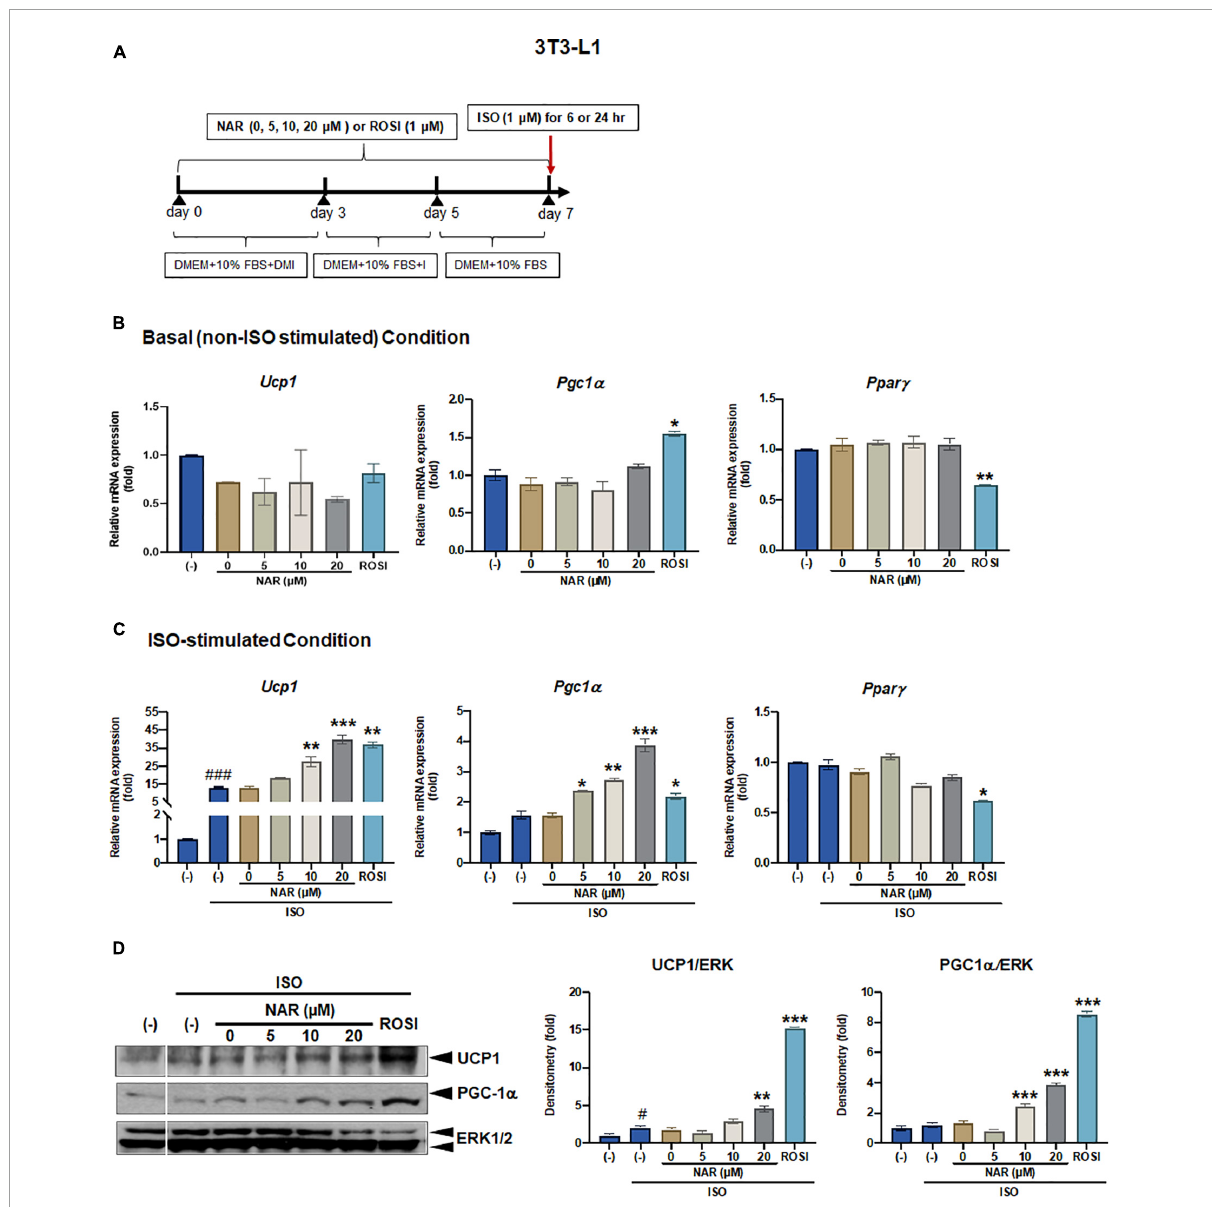
FIGURE1 Naringenin dose-dependently enhances UCP-1 expression in isoproterenol (ISO)-stimulated 3T3-L1 adipocytes. 3T3-L1 cells were differentiated in the presence or absence of NAR (5, 10, 20 µ M) for 7 days. ROSI (1 µ M) was included as a positive control. On day 7, the cells were stimulated with isoproterenol (ISO, 1 µ M) or the vehicle control (H 2 O) for 6 h for mRNA analysis or 24 h for protein analysis. (A) A diagram of the cell treatment and timeline. As described in the Materials and Methods, DMEM + 10% FBS + DMI refer to DMEM containing 10% FBS, 0.5 mM/L 3-isobutyl-1-methylxanthine, 1 µ M/L dexamethasone, and 10 µ g/mL insulin. DEME + 10% FBS + I refer to DMEM containing 10% FBS and 10 µ g/mL insulin. DMEM + 10% FBS refer to DMEM containing 10% FBS. (B,C) Relative mRNA levels of Ucp1, Pgc1 α , and Ppar γ at the basal (B) and ISO-stimulated conditions (C) . mRNA expression is presented relatively to the loading control 36b4 . (D) Protein expression of UCP1, PGC1 α , and the loading control ERK1/2. Bar graphs show the densitometry of each protein to the loading control ERK1/2. Data = Mean ± SEM ( n = 3). *, **, *** p < 0.05, p < 0.01, and p < 0.001 compared to the 0 µ M NAR (i.e., DMSO) samples, respectively (B–D) . #, ### p < 0.05, p < 0.001 compared to the non-ISO stimulated (–) samples, respectively (C,D)